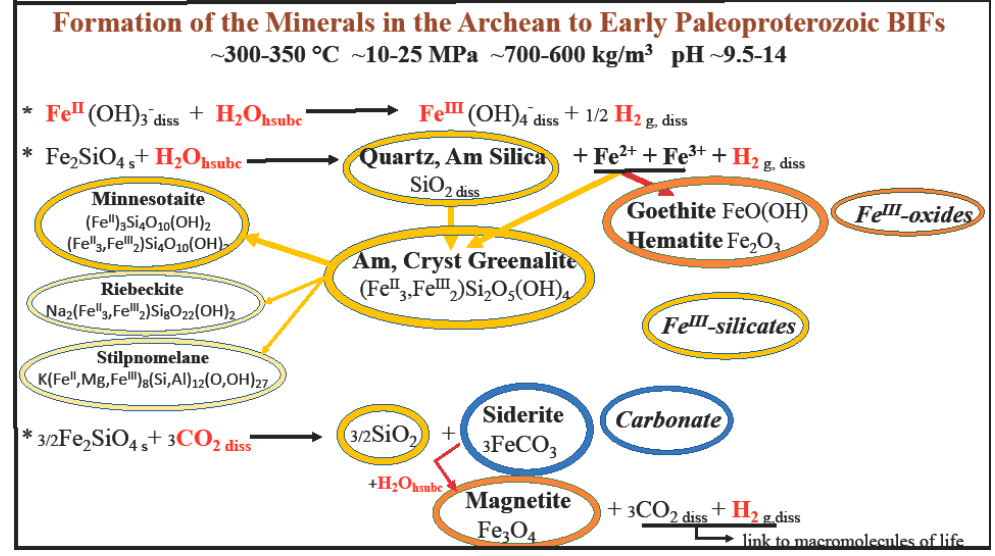
Figure 5. A possible formation of ferric minerals in the absence of UV light, oxygen, and microorganisms. The specific case of banded iron formations (BIFs) is illustrated. Synthesized minerals are as follows; in brown: quartz and amorphous silica and the ferric silicate greenalite and its dehydration product minnesotaite; in light brown: riebeckite and stilpnomelane, which may possibly be considered as dehydration products of greenalite; in rusty red: the ferric oxides goethite and hematite, and magnetite arising from siderite; in blue: the carbonate siderite. This is an extended version of Figure 1 in Bassez 2018 [7]; it includes the action of CO 2 on fayalite and the formation of magnetite from siderite.